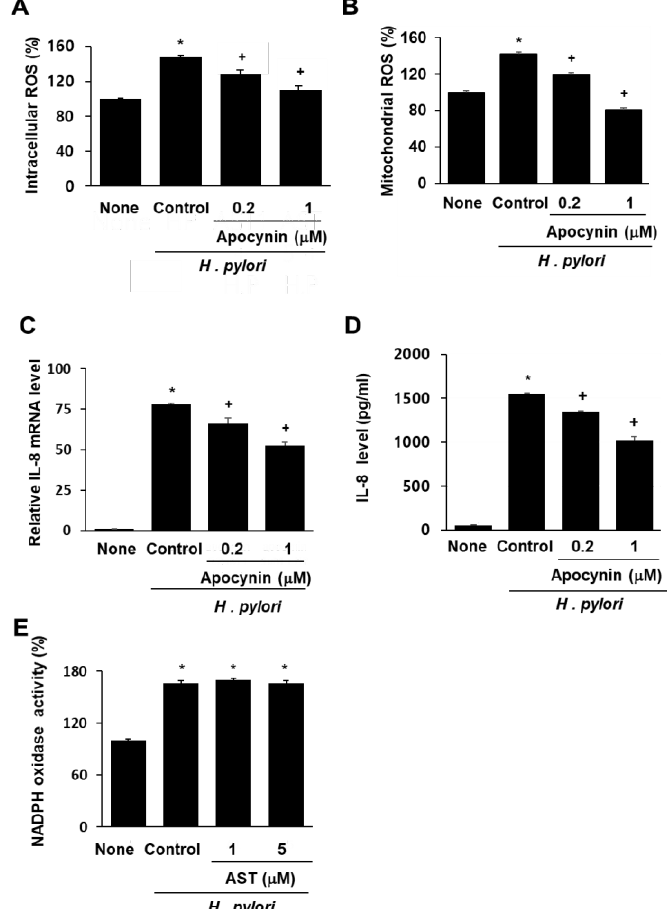
Figure 3. Effect of apocynin on ROS levels and IL-8 expression and effect of astaxanthin on NADPH oxidase activity in H. pylori -infected AGS cells. The AGS cells were pre-treated with the indicated concentrations of a NADPH oxidase inhibitor apocynin for 3 h and then stimulated with H. pylori for 1 h (for intracellular and mitochondrial ROS levels), 4 h (for IL-8 mRNA level), and 24 h (for IL-8 protein level in the medium). ( A ) Plot of the relative ROS level in AGS cells measured by DCF-DA fluorescence. Column “None” corresponds to uninfected AGS cells, column “Control” to H. pylori -infected AGS cells, and columns “0.2” and “1” to H. pylori -infected AGS cells pretreated with 0.2 and 1 µ M apocynin, respectively. ( B ) Plot of the relative mitochondrial ROS level in AGS cells measured by MitoSOX fluorescence. The description of the columns is the same as in ( A ). ( C ) mRNA expression of IL-8 was determined by real-time PCR analysis. The description of the columns is the same as in ( A ). ( D ) Plot of the relative concentration of IL-8 in the media of cultured AGS cells determined by using the ELISA method. The description of the columns is the same as in ( A ). ( E ) Plot of the relative NADPH oxidase activity in AGS cells. The cells were pre-treated with 5 µ M astaxanthin for 3 h and then stimulated with H. pylori for 1 h. NADPH oxidase activity was measured by lucigenin assay. The description of the columns is the same as in ( A ). * p < 0.05 vs. None; + p < 0.05 vs.